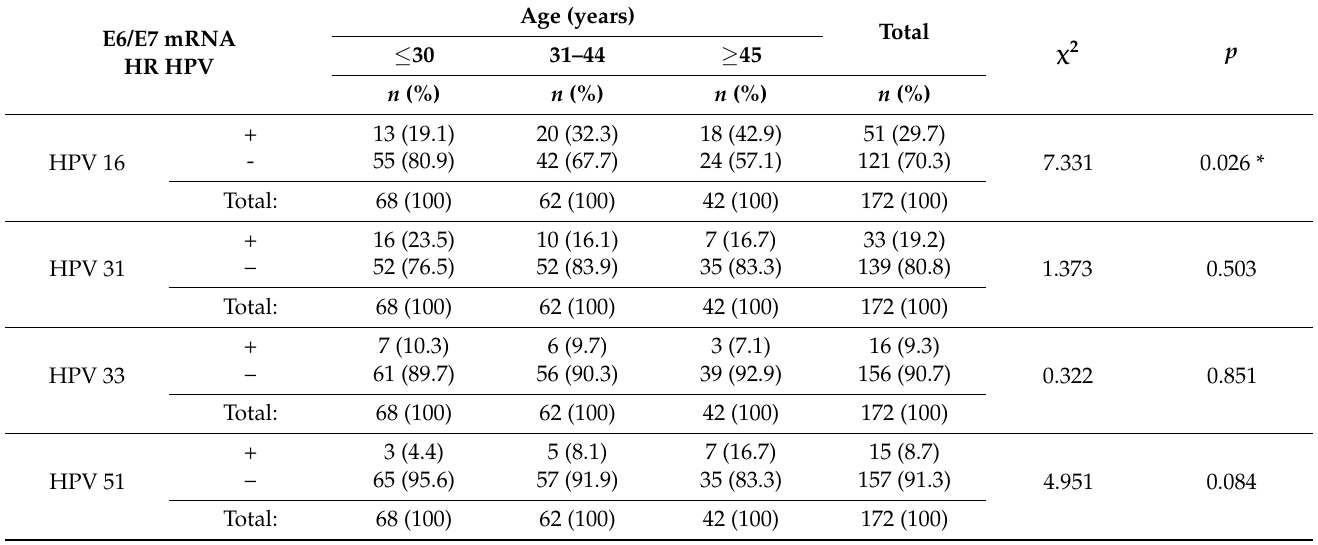
Table 9. Analyses of E6/E7 mRNA HPVs according to age.